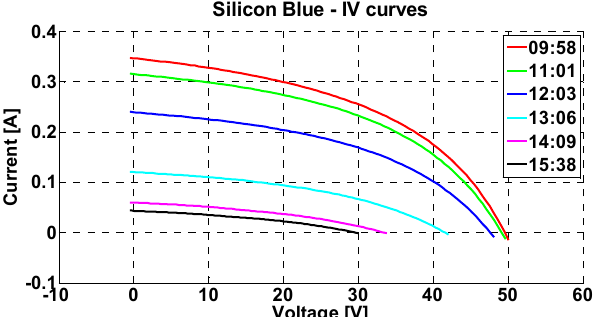
Figure 18. Blue silicon cell current-voltage curves for different irradiance values.